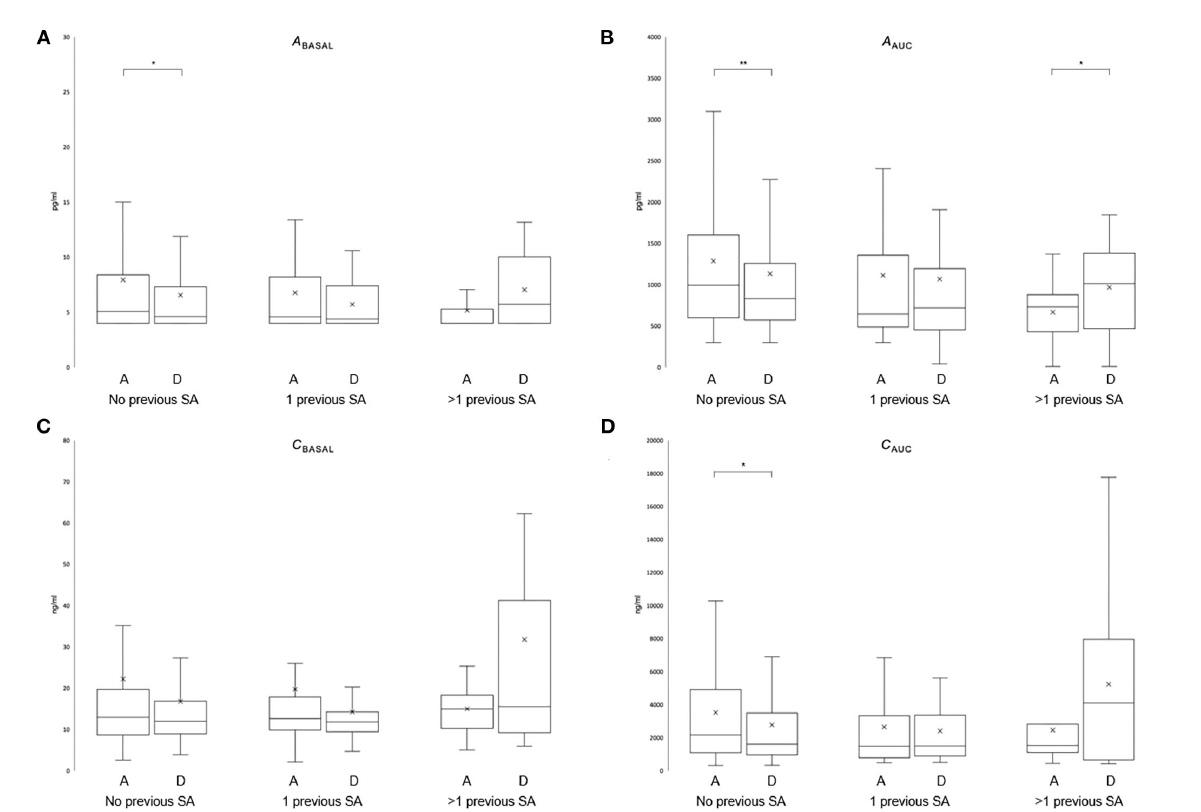
FIGURE1 Effect of previous suicide attempts on the HPA axis during recovery of depression. Stress hormone levels in the dex/CRH test are depicted [A bas (A) ; A AUC (B) ; C basal (C) ; C AUC (D) ] at hospital admission (A) and discharge (D) in patients without previous SA ( N = 181), with one previous SA ( N = 43) or more than one previous SA ( N = 13). The Wilcoxon test for paired samples (see text for details). The whisker lines correspond to highest and lowest values no further than the 1.5 interquartile range from the hinges. Median lines are indicated across the boxes, and mean values are indicated with an × (* P < 0.05; ** P <